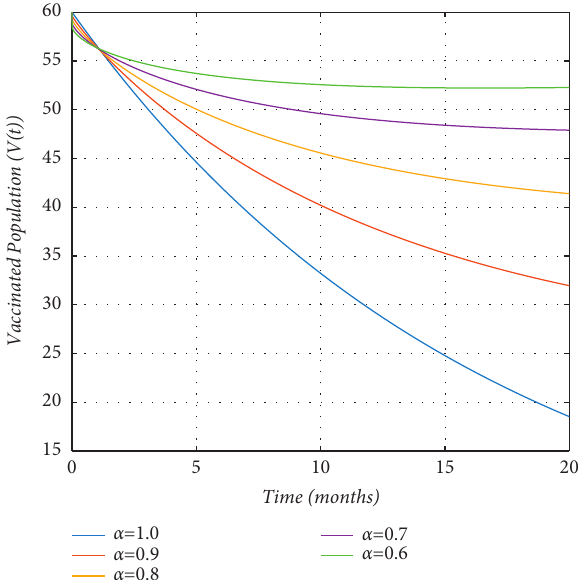
Figure 5: The graph demonstrates the dynamics of the vaccinated population against different values of the fractional-order pa- rameter ( α ), and the initial sizes of the population are ( 100 , 90 , 80 , 70 , 60 )